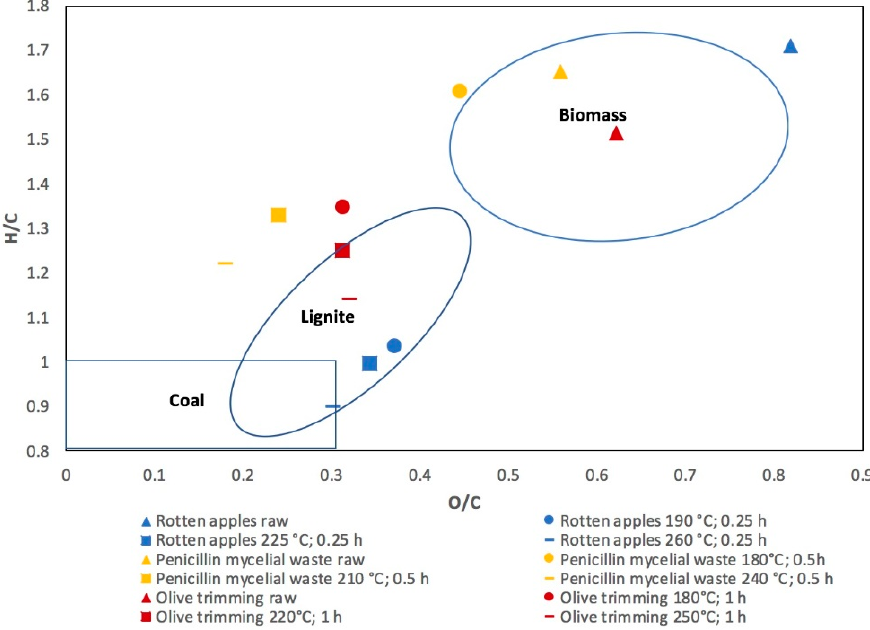
Figure 3. van Krevelen diagram of hydrothermal carbonization (HTC) treatment of rotten apples, Penicillin mycelial and olive trimming.